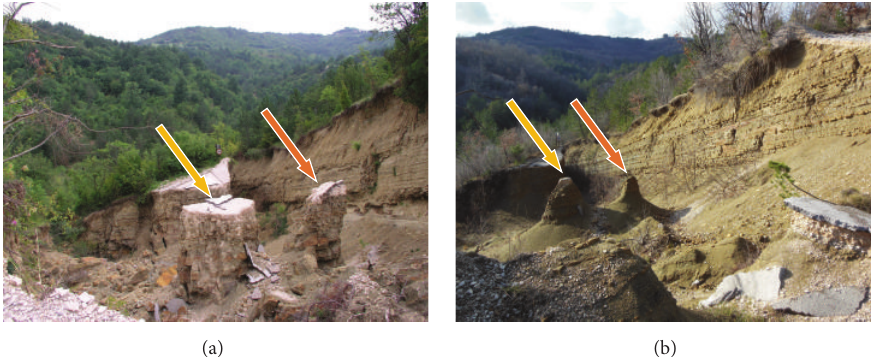
Figure 4: View of a landslide body and lateral scarp from the crown of the Brus Landslide in (a) August 2005 and (b) January 2013. Table 1: Mineralogical compositions of siltstone samples of different weathering grades [30]. Sample